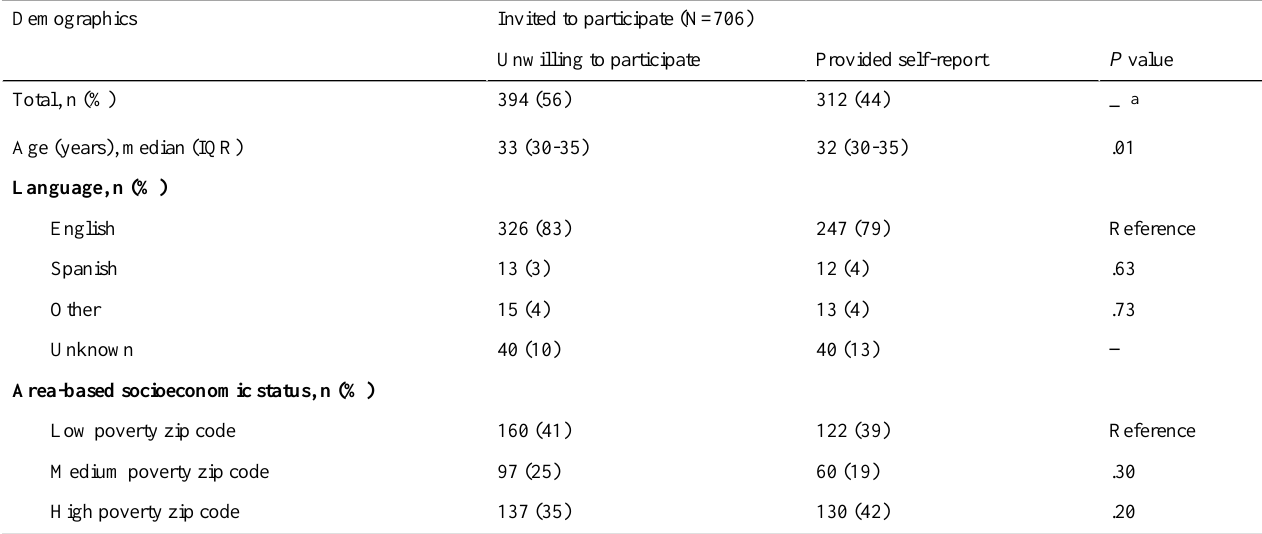
Table 1. Willingness to participate and provide self-report of immunization history.